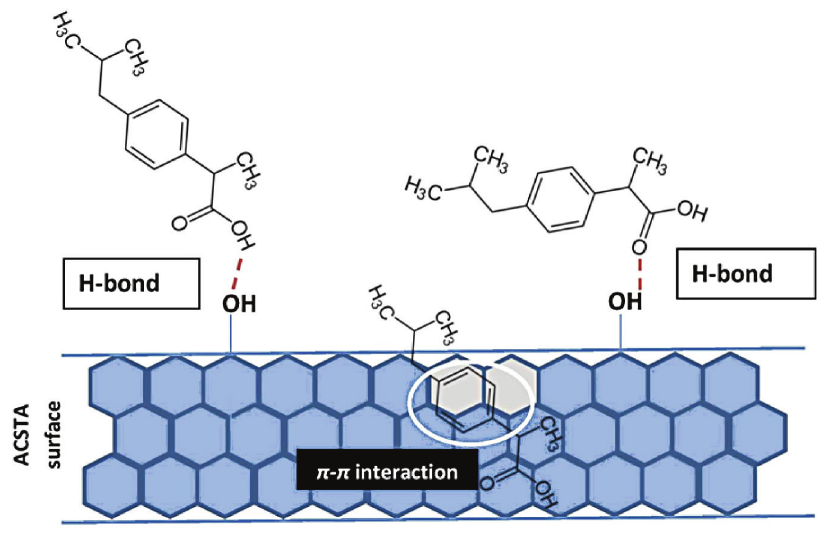
Fig. 9 – Physicochemical interaction between ACSTA surface functional groups and IBU